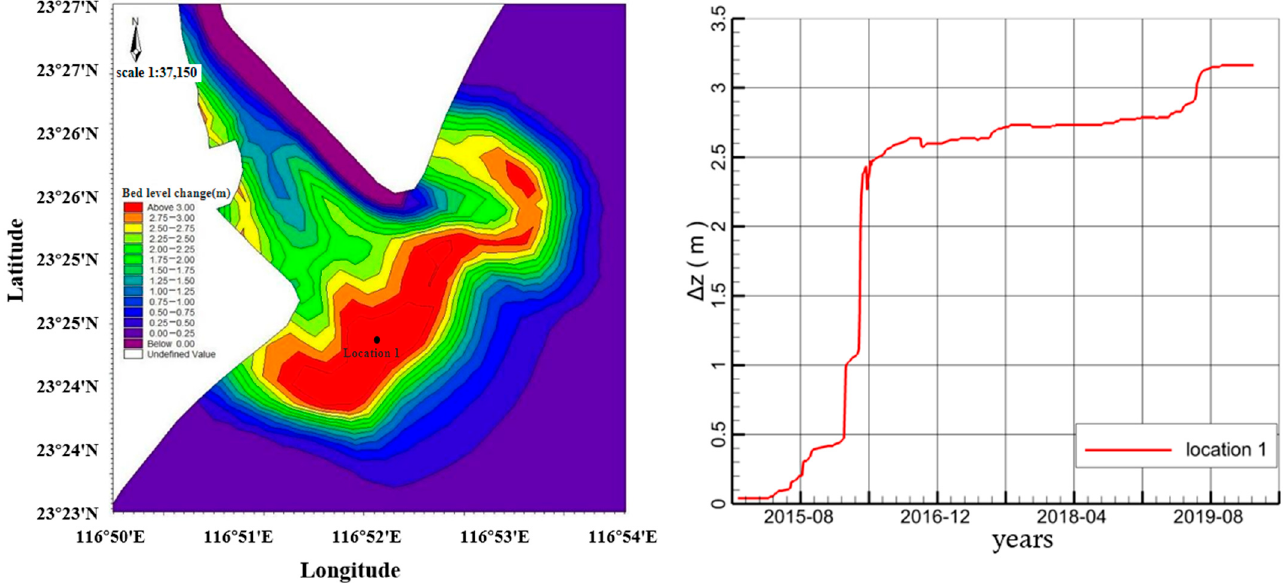
Figure 14. Changes of sedimentation thickness of Waishahe in 5 years.